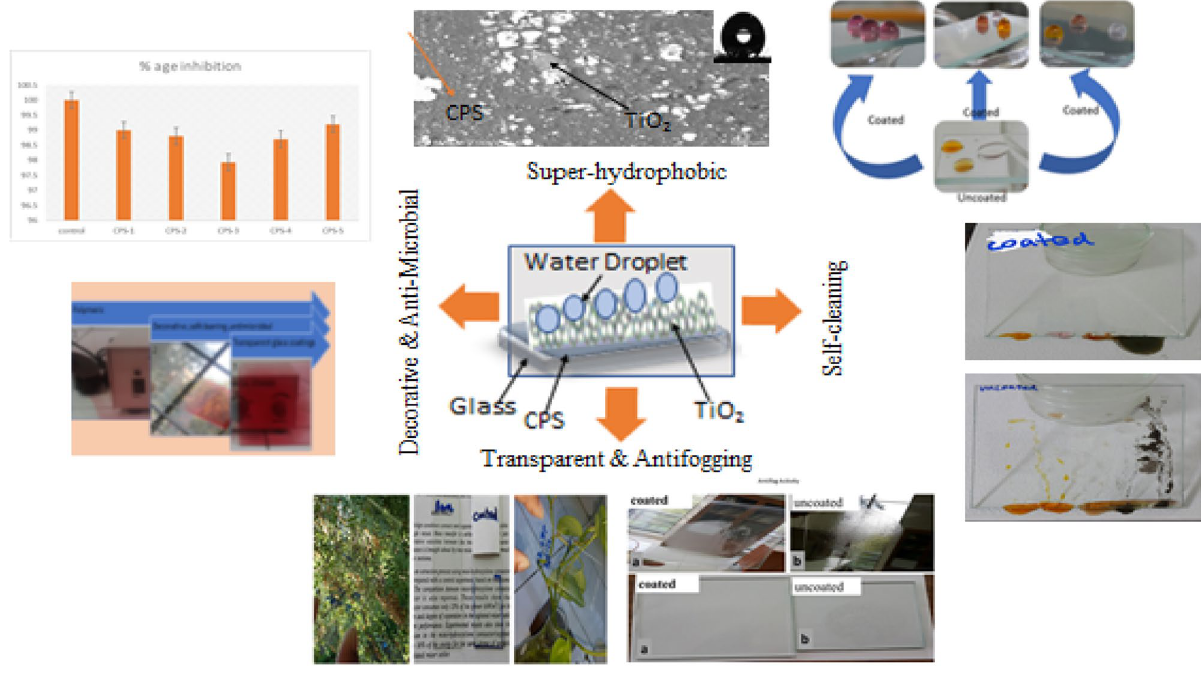
Figure 1. Graphical